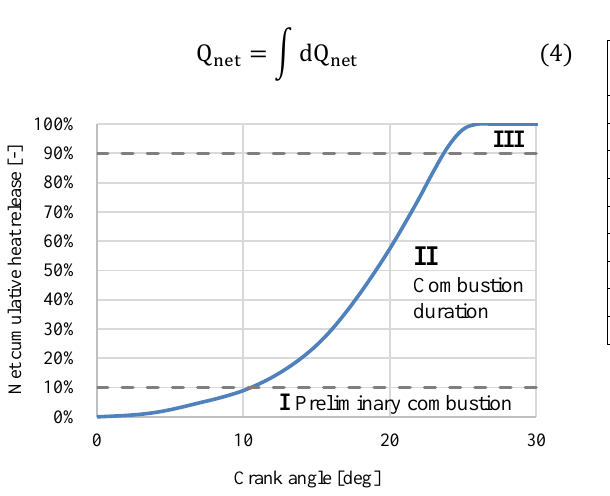
Fig. 3. The course of heat release as a result of butanol combustion in the UIT-85 engine